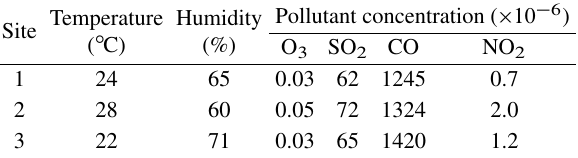
Table 1 Measurement results of pollutant concentrations at the